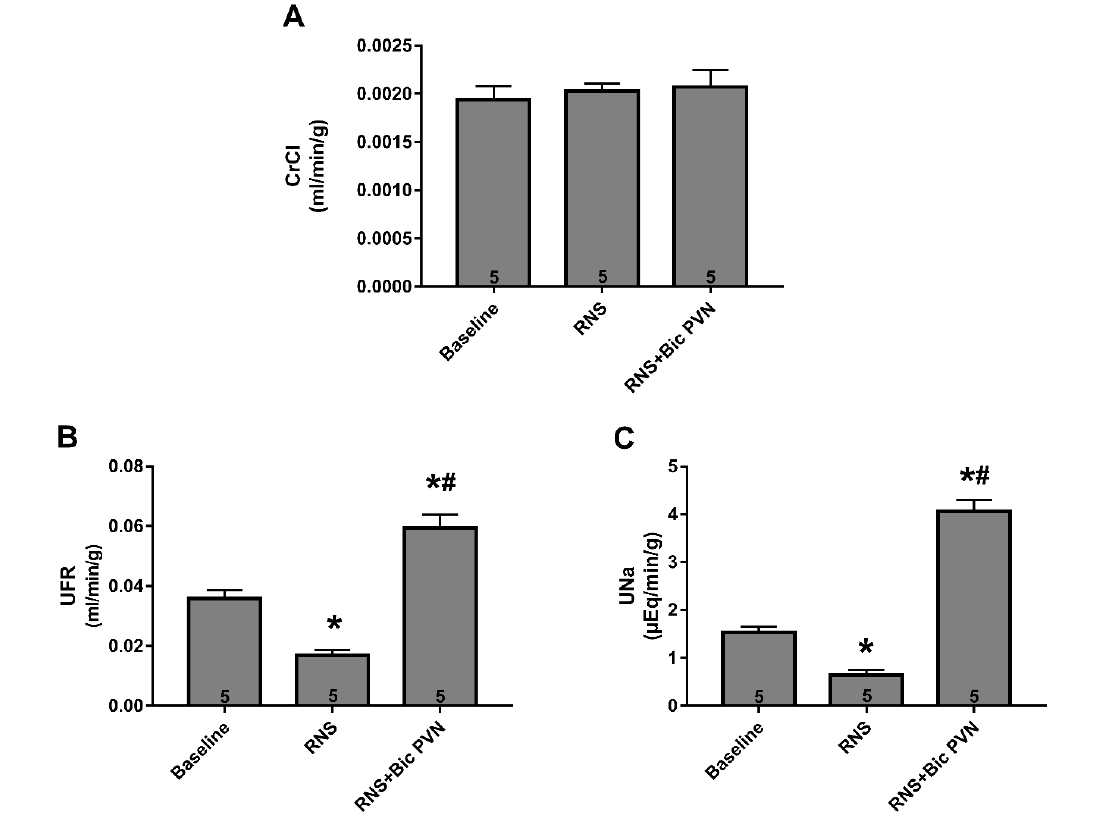
Figure 5. Creatinine clearance (CrCl), urinary flow rate (UFR), and urinary sodium rate (UNa) at three time points. ( A ) CrCl at baseline, under renal nerve stimulation (RNS), and under RNS plus bicuculline injection into the paraventricular nucleus of the hypothalamus (Bic PVN). ( B ) UFR at baseline, under RNS, and under RNS + Bic PVN. ( C ) UNa at baseline, under RNS, and under RNS + Bic PVN. The number of rats samples is shown inside the bars. * p < 0.001 compared to baseline. # p < 0.001 compared to RNS. One-way analysis of variance for multiple comparisons followed by Tukey ’ s test.